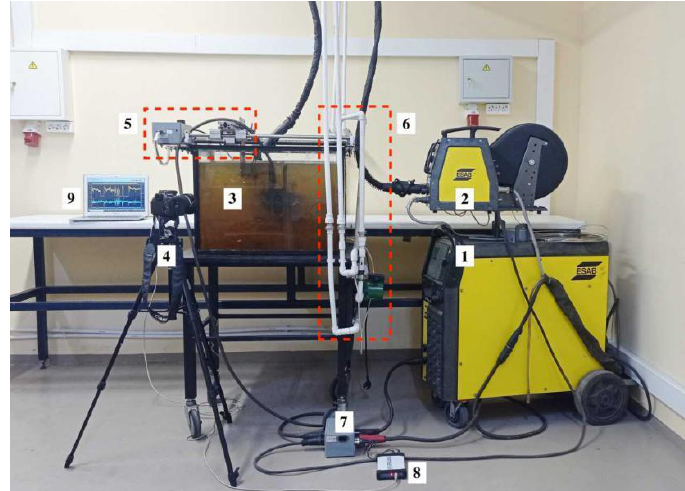
Figure 1. Underwater wet cutting setup: ( 1 ) source of power; ( 2 ) wire feed system; ( 3 ) water tank; ( 4 ) video camera; ( 5 ) automat of torch movement; ( 6 ) water supply system and pump; ( 7 ) welding current and arc voltage sensors; ( 8 ) USB-oscilloscope; ( 9 ) laptop.